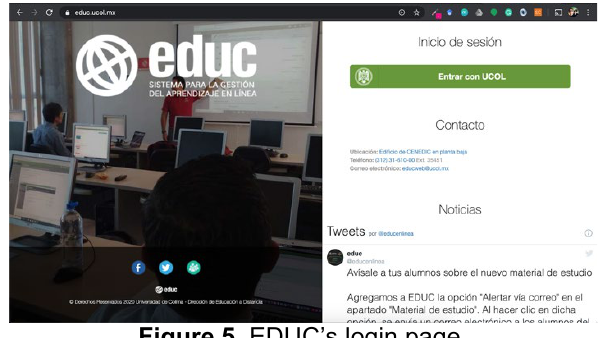
Figure 4. Example of an automatic tool for Figure 5. EDUC’s login page.